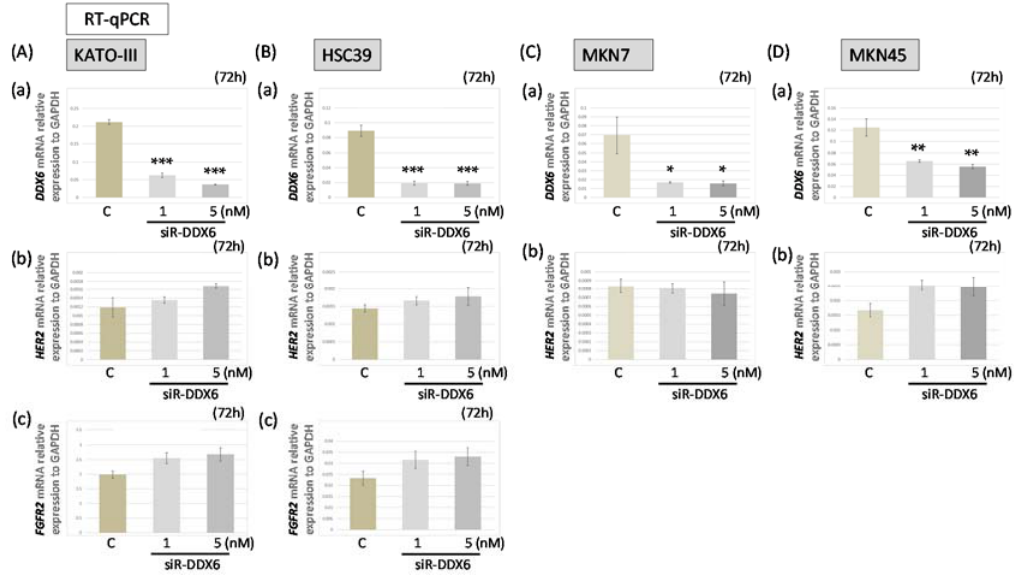
Figure 4. The HER2 and FGFR2 mRNA levels in MKN7, MKN45, HSC39, and KATO ‐ III cells after knockdown of DDX6 in the cells. ( A , B ) The expression levels of DDX6 (a), HER2 (b), and FGFR2 (c) mRNAs at 72 h after transfection of KATO ‐ III ( A ) and HSC39 ( B ) cells with siR ‐ DDX6; ( C ): control RNA, 5 nM; ( C , D ) Expression levels of DDX6 ( a ) and HER2 ( b ) mRNAs at 72 h after transfection of MKN7 ( C ) and MKN45 ( D ) cells with siR ‐ DDX6. (C: control RNA, 5 nM) The levels of controls are indicated as “1.” Results are presented as the mean ± SD. * p < 0.05; ** p < 0.01; *** p < 0.001.